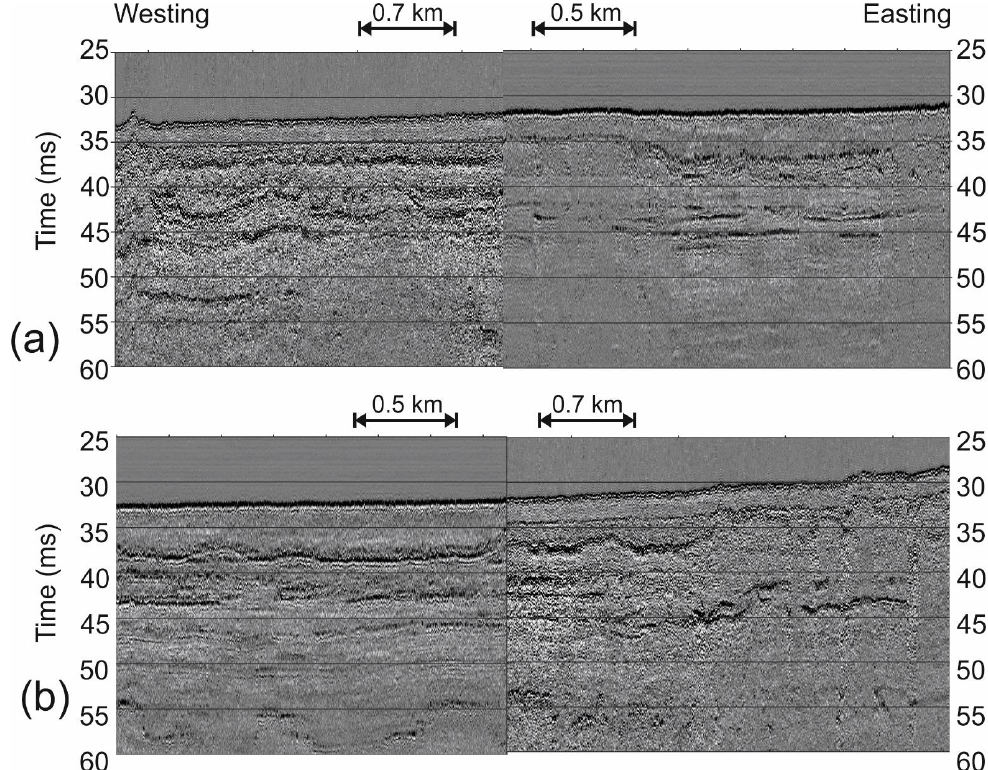
Figure 12. Details at the intersection point of the Boomer and Chirp profiles after a spike deconvolution: Boomer-Chirp ( a ) and Chirp-Boomer ( b ). The Boomer data are noisier, but their lower frequencies penetrate further than do the better- resolved Chirp data.